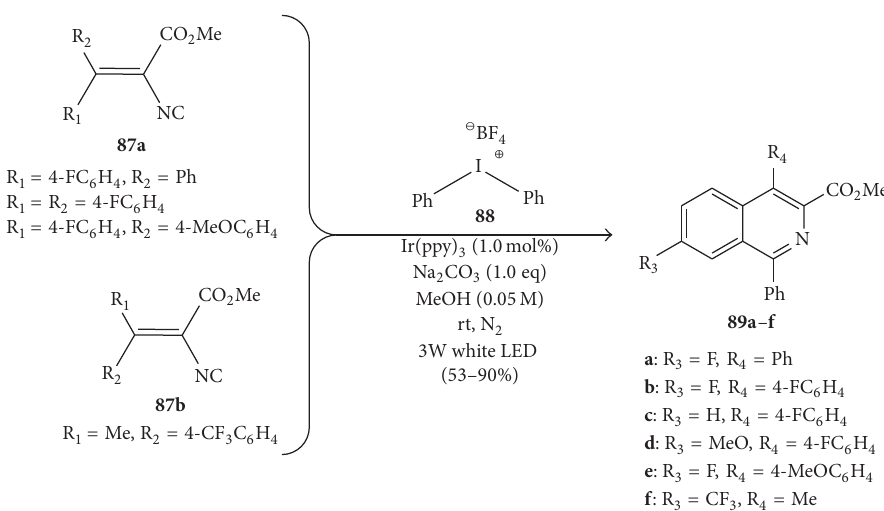
Scheme 20: Iridium catalyzed fluoroisoquinoline and trifluoromethylisoquinoline